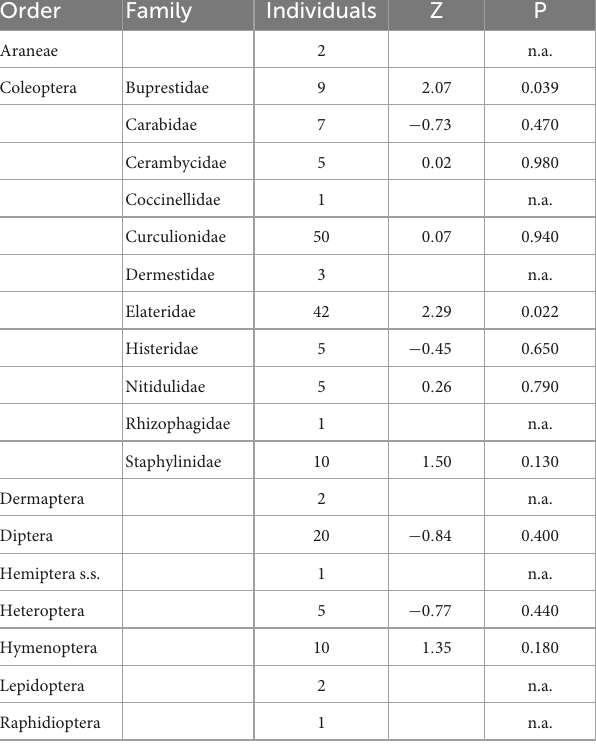
TABLE 6 Results of the association of the nontarget arthropods (in alphabetic order) with the abundance of the oak pinhole borer in the pheromone-baited traps in 2017 in the